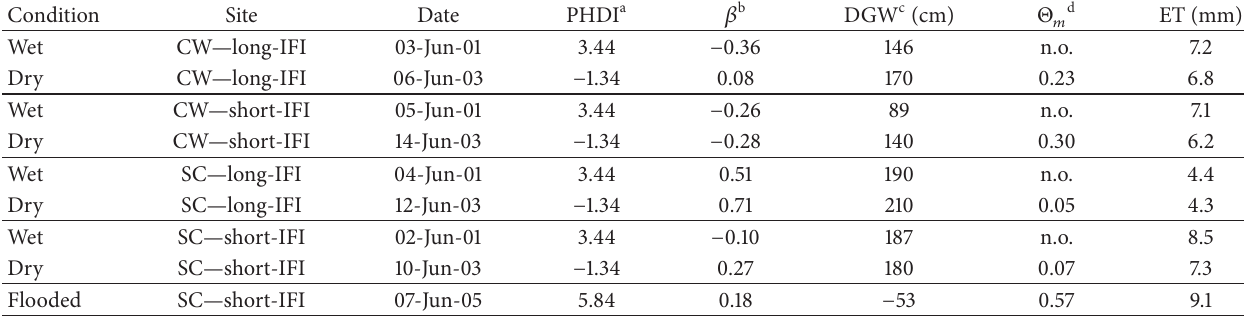
Table 2: Surface conditions on representative cloud-free days.